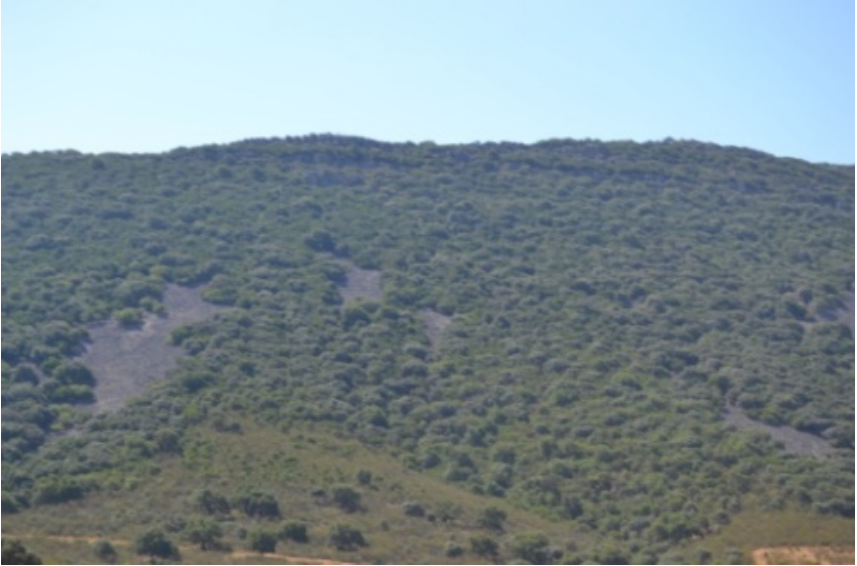
Figure 14. Poterio agrimonioidis – Quercetum suberis .